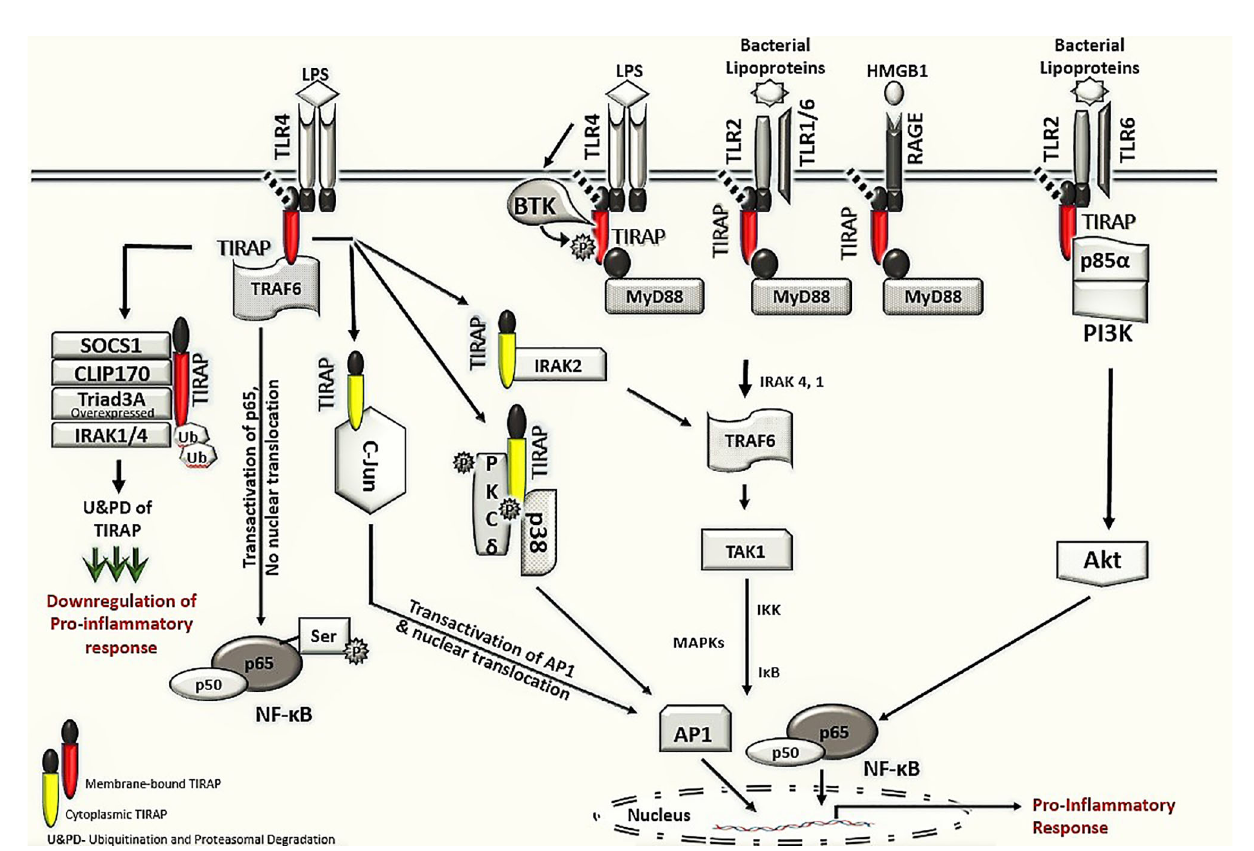
FIGURE 2 | TIRAP interacting machinery in the activation of in fl ammatory signaling. The membrane localized TIRAP initiates the downstream signaling via its interaction with upstream membrane bound receptors TLR4, TLR2 and RAGE as well as with membrane localized kinases BTK, p85 a subunit of PI3K and BCAP. In TLR4 mediated signaling, the membrane localized TIRAP also interacts with TRAF6 for transactivation of the p65 in NF- k B pathway. The downstream in fl ammatory signaling via cytoplasmic TIRAP involves an interaction with protein kinase PKC d and p38 MAPK as well as with IRAK2 and AP-1 subunit c-Jun, respectively. The negative regulators of TIRAP protein including SOCS1, CLIP170, IRAK1/4 and Triad3A are involved in interactions with TIRAP for its ubiquitination and proteasomal degradation (U&PD) and hence downregulation in in fl ammatory response mediated via TIRAP. TLR- Toll -interleukin-1 receptor; TIRAP- Toll-interleukin-1 Receptor (TIR) domain-containing adaptor protein; MyD88- Myeloid differentiation factor 88; RAGE- Receptor for advanced glycation end-products; BTK- Bruton ’ s tyrosine kinase; PI3K- phosphoinositide 3-kinase; BCAP- B-cell adaptor for phosphoinositide 3-kinase; TRAF6, Tumor necrosis factor receptor (TNFR)-associated factor 6; NF- k B, Nuclear Factor kappa-light-chain-enhancer of activated B cells; PKC d , protein kinase c delta; p38 MAPK, p38 mitogen-activated protein kinase; AP-1, Activator protein 1; SOCS1, Suppressor of cytokine signaling 1; CLIP170, Cytoplasmic linker protein 170; IRAK, interleukin-1 receptor-associated kinase; IKK, I k B kinase; and I k B, nuclear factor of kappa light polypeptide gene enhancer in B-cells